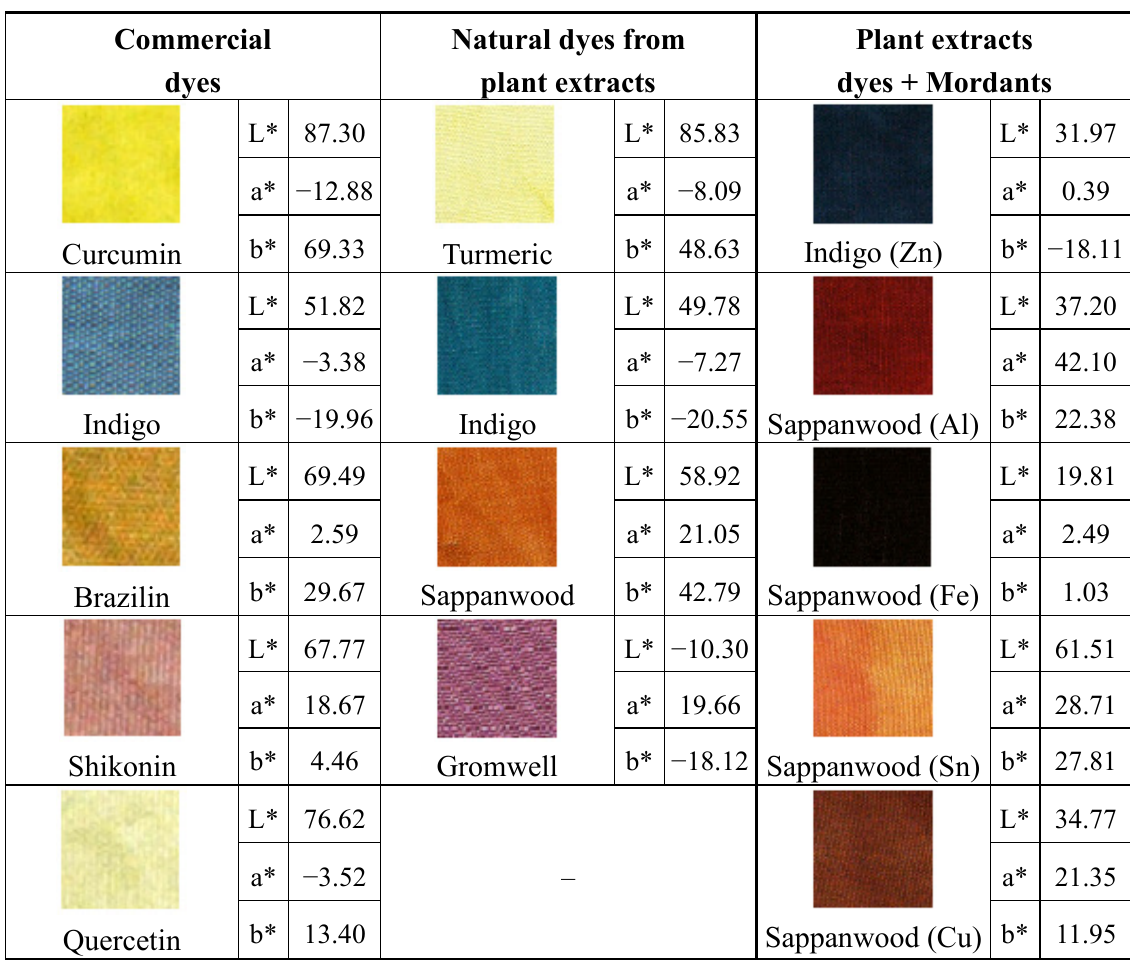
Table 2. Various colors and colorimetric data of silk fabric dyed with commercial dyes, plant extracts dyes and plant extracts dyes with mordants. (L*,a*,b* is CIELAB color